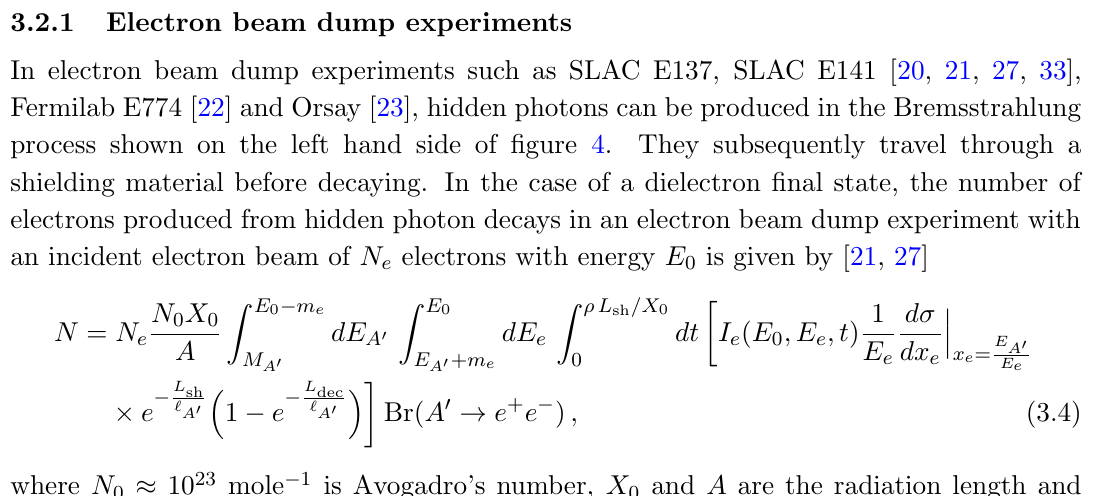
Figure 4 . Hidden photon production through Bremsstrahlung (left) and meson production (right) in beam dump